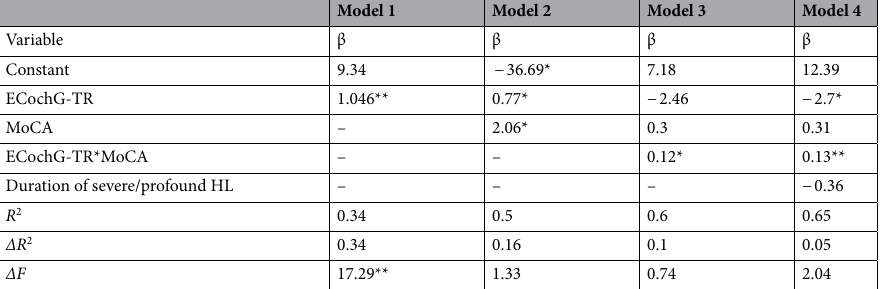
Table 2. The hierarchical multiple regression analysis for predicting AZBio + 10 SNR scores with four different models (model 1: addition of electrocochleography total response (ECochG-TR), model 2: addition of Montreal Cognitive Assessment (MoCA) score, model 3: addition of two-way interaction between MoCA and ECochG-TR, model 4: addition of duration of severe/profound hearing loss (HL)). ΔR 2 represents the variation in the dependent variable explained by the specific independent variable. ECochG-TR (model 1) improved the prediction of postoperative performance in noise as measured by AzBio + 10 dB signal-to-noise ratio considerably ( ΔR 2 = 0.34, ΔF = 17.29). β = standardized regression coefficient; * p = < 0.05; ** p = <